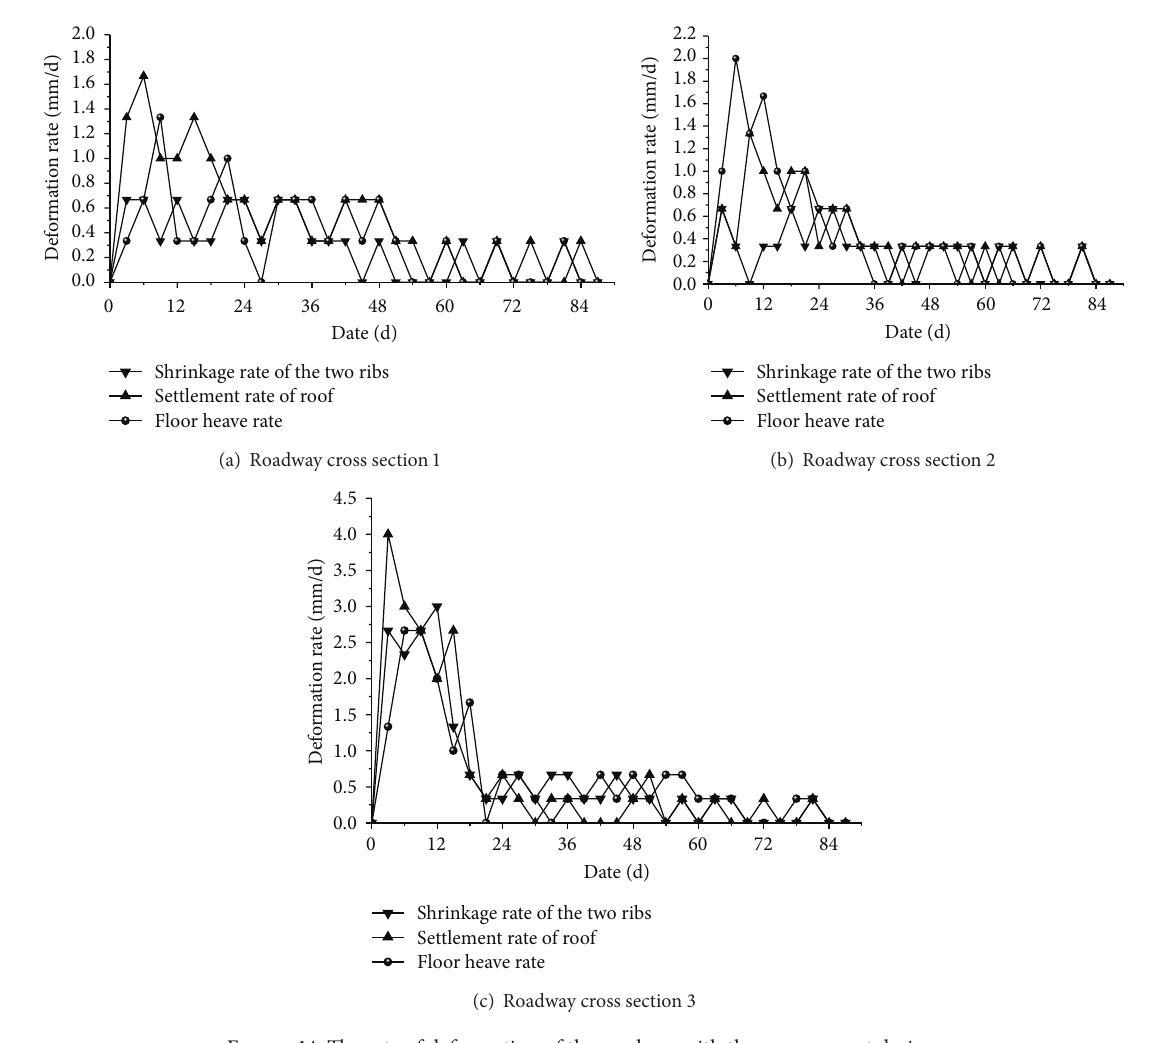
Figure 14: The rate of deformation of the roadway with the new support design.